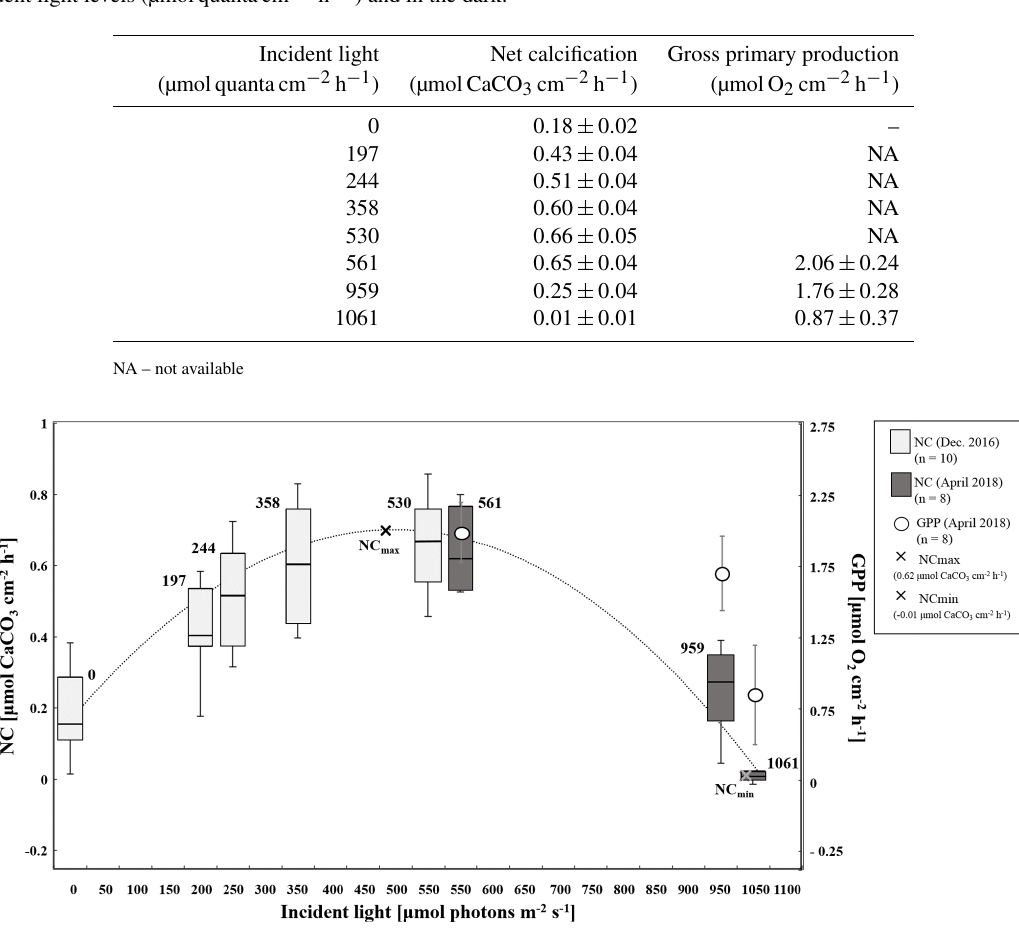
Table 1. Net calcification (µmolCaCO 3 cm − 2 h − 1 ; ± SE) and gross primary production (µmolO 2 cm − 2 h − 1 ; ± SE) under the seven exper- imental incident light levels (µmolquantacm − 2 h − 1 ) and in the dark.